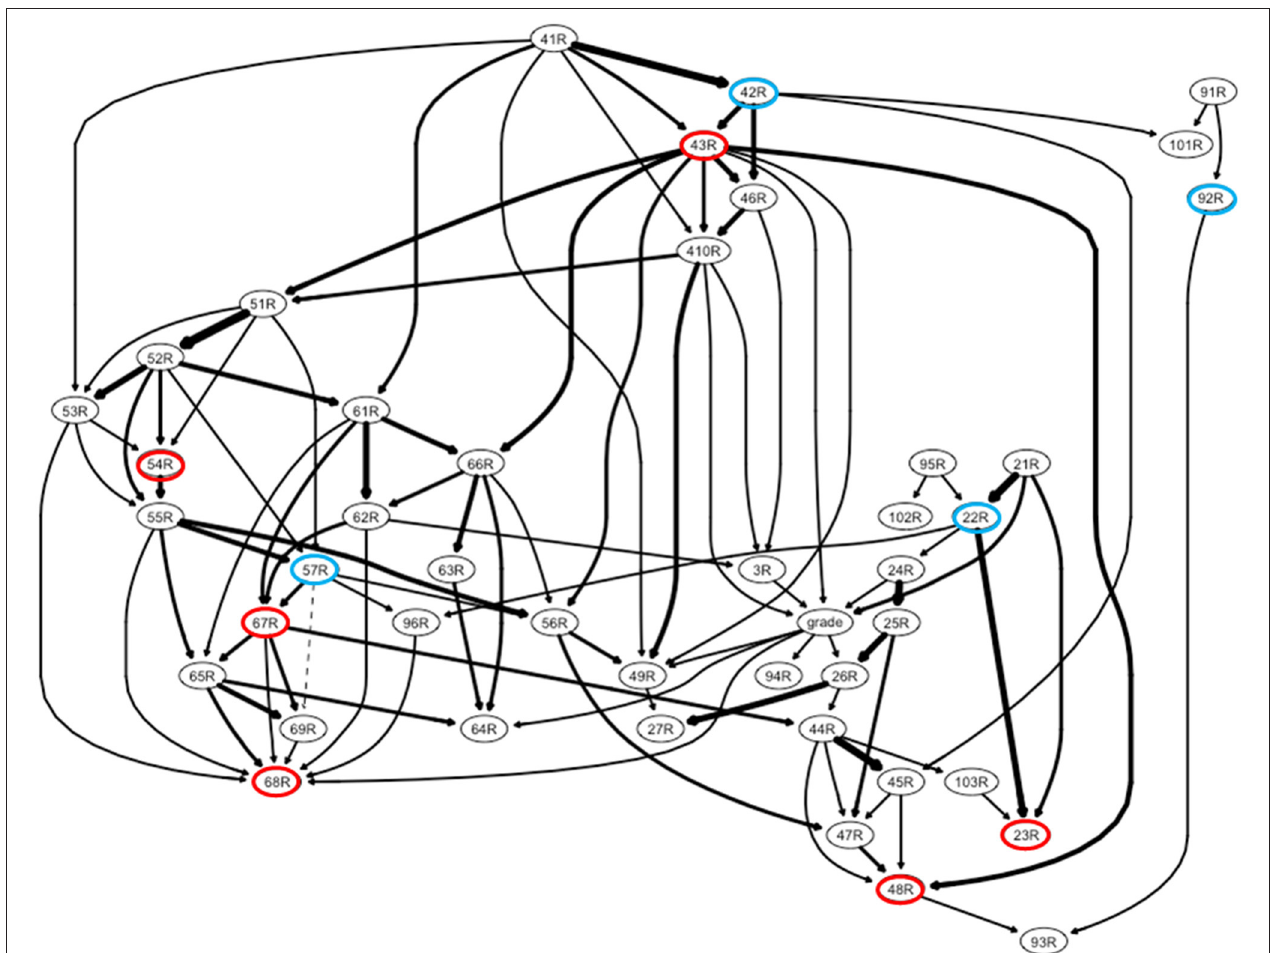
FIGURE 1 | A directed acyclic graph of changes in lifestyle, personal attitudes, perceived stress, anxiety, and depressive mood among Korean medical students during the COVID-19 pandemic. The following six most influential items are marked with red circles: (1) personal attitude, fear of infecting my colleagues (R23); (2) perceived stress, feeling nervous and stressed (R43); (3) perceived stress: feeling “being on top of things” (R48); (4) anxiety, trouble relaxing (R54); (5) depressive mood, feelings of failure or that I have let myself/family members down (R67); and (6) depressive mood, trouble concentrating on things such as reading the newspaper or